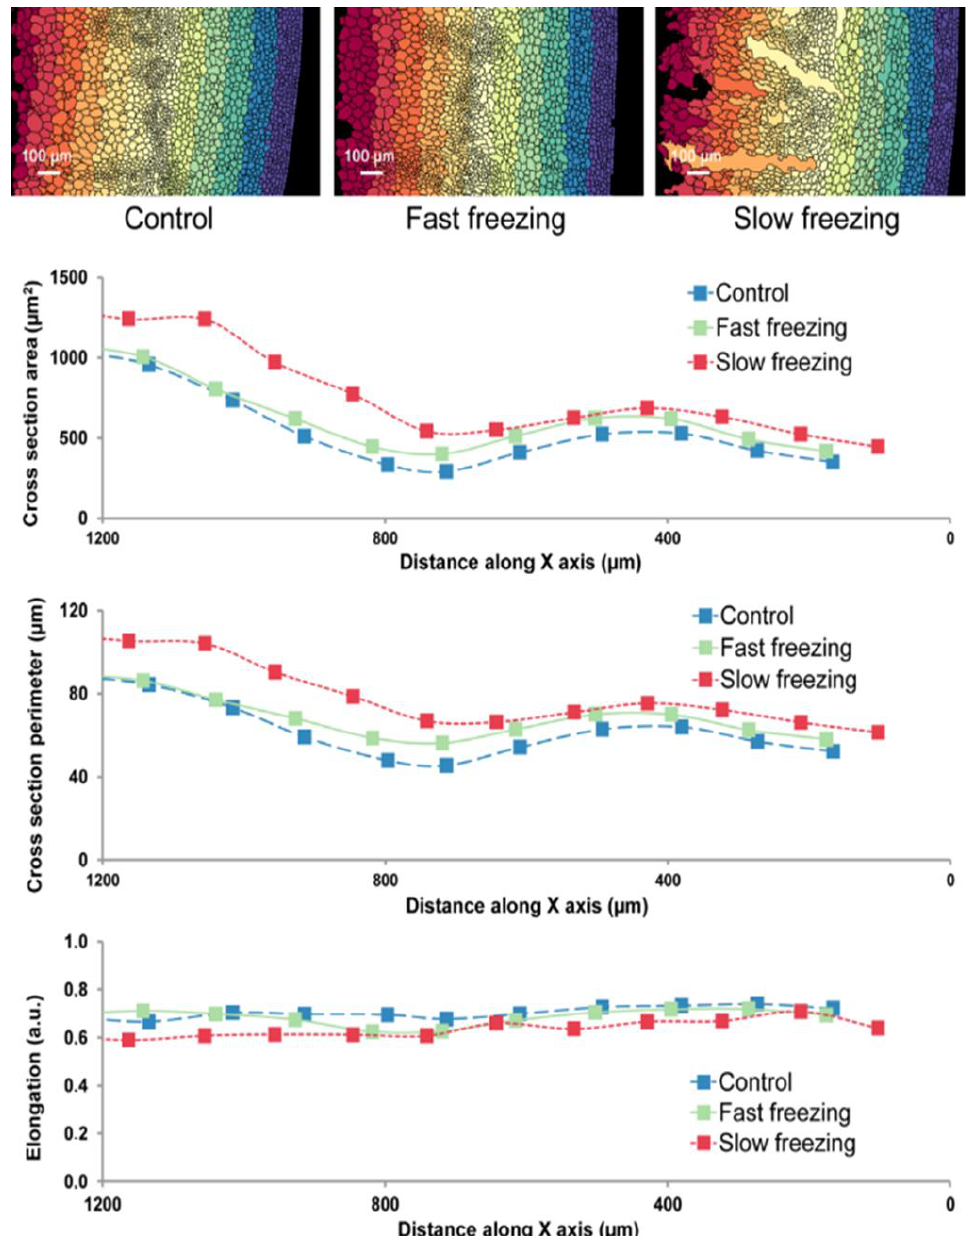
Figure 3. Analysis mosaic of microscopic images of tissue made of broccoli in a plane perpendicular to the axis of the stem for three types of treatment samples. For analysis, the objects were divided into groups depending on the distance from the edge of the sample (the division into groups is shown in the colour maps in the upper part of the drawing). The graphs show the average values of the geometrical parameters of the cells within the designated groups, the horizontal axis indicates the distance in micrometres from the right edge of the image (from the stem epidermis).